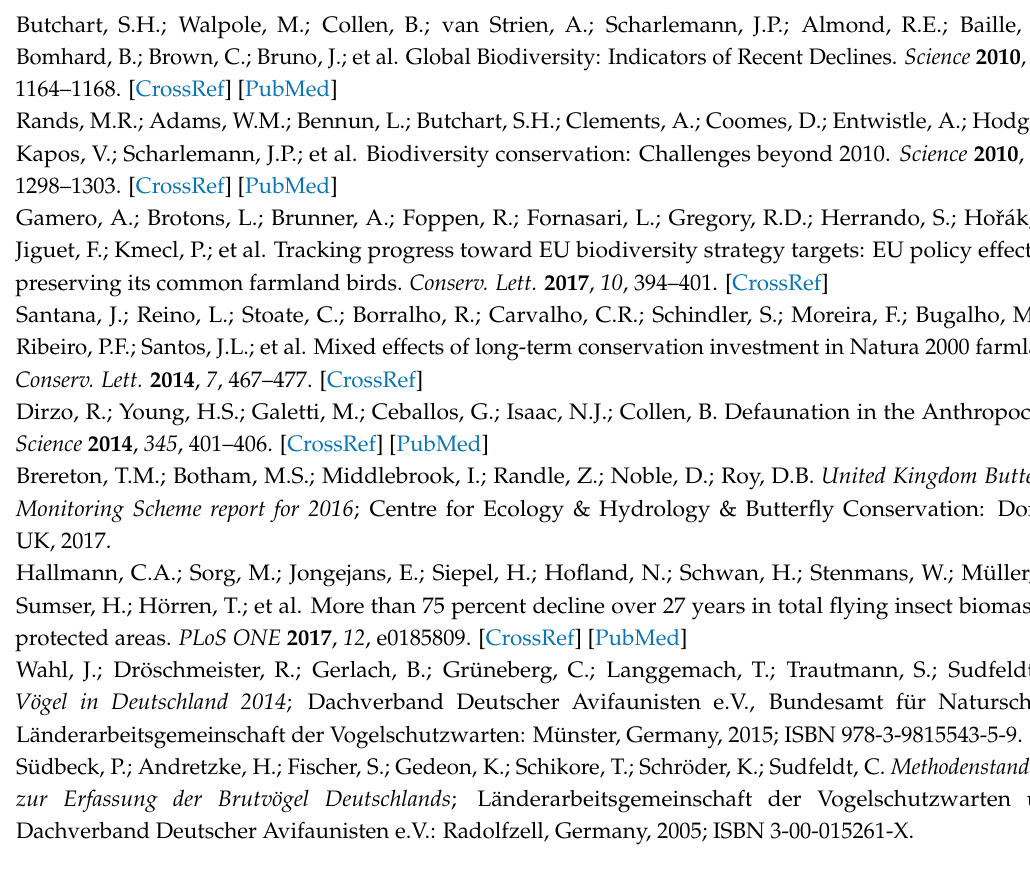
Figure S1: Species map for Great Spotted Woodpecker with single detections and defined territories; Figure S2: Species map for Bluethroat with single detections and defined territories; Figure S3: Species map for Eurasian Skylark with single detections and defined territories; Figure S4: Species map for Red-backed Shrike with single detections and defined territories; Table S1: Long-term (from 1974–1979 to 2017) and short-term (2003–2017) trends of breeding bird populations at “Lampertheimer Altrhein” (LA) in comparison with long-term (1985–2009) and short-term (1998–2009) trends for Germany [1] and long-term (1980–2011) and short-term (1990–2011) trends for Europe [2]. Every species is classified into categories of habitat use and food requirements. Species are sorted from negative to positive population developments in the long-term